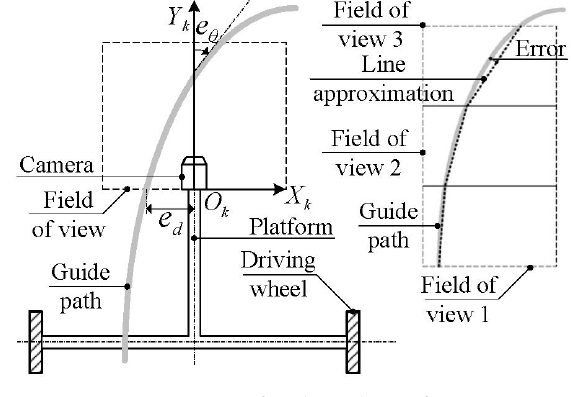
Figure 2. Top view of path tracking of a DWMR. Table 1. Linearization